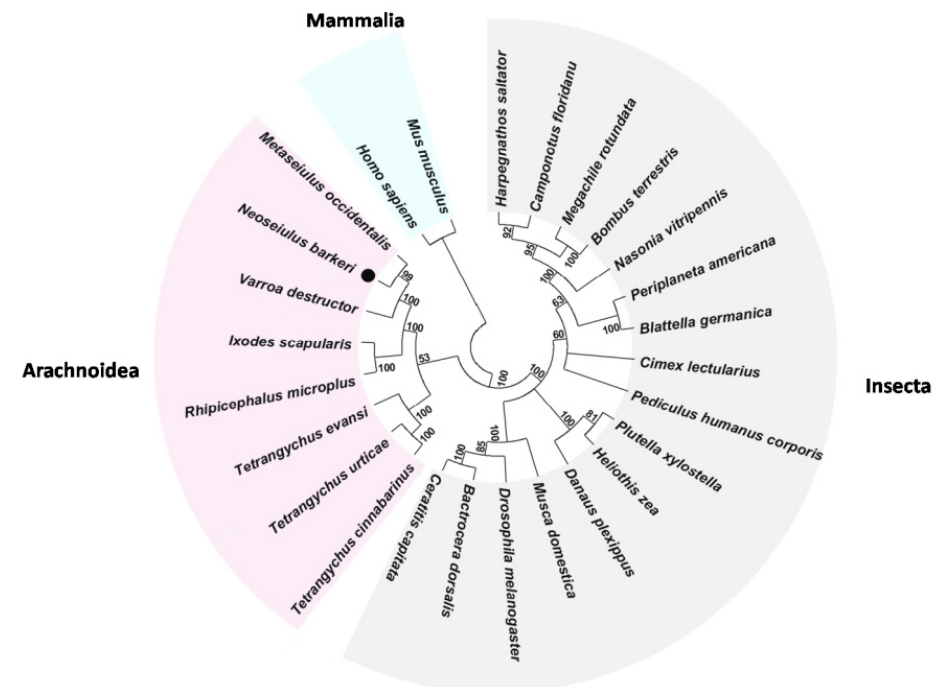
Figure 1. Phylogenetic analysis of sodium channels. The amino acid sequences generated from N. barkeri and 25 other species were selected to construct the phylogenetic tree using the Neighbor-joining method with a bootstrap value of 1000. The dot represents the protein sequence of the N. barkeri sodium channel.